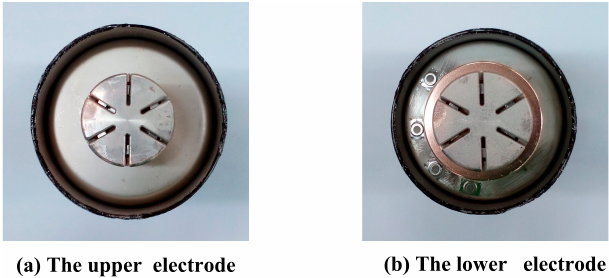
Figure 5. CuCr50 electrodes after several experiments.